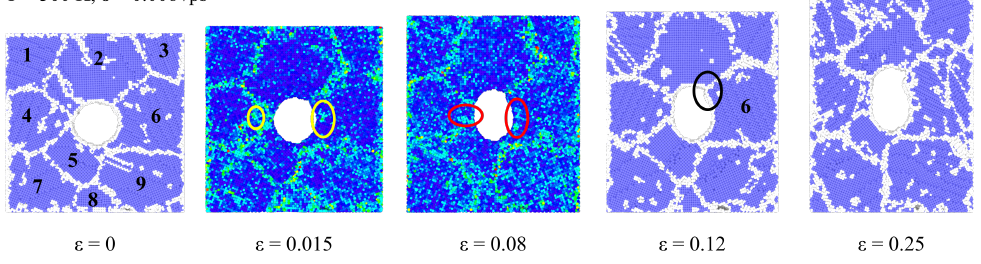
Figure 5. Sanpshots of specimen with a hole during the tesile